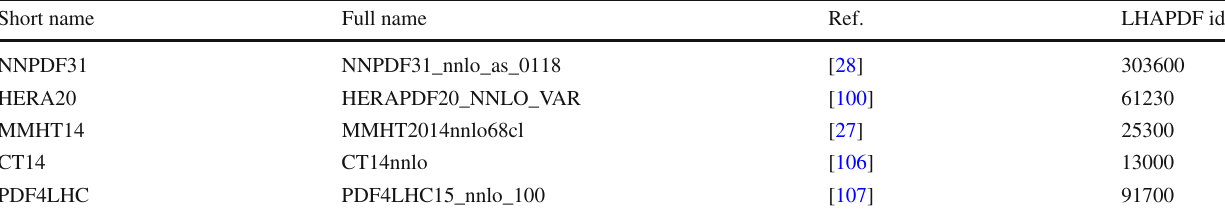
Table 4 List of collinear PDF used as the boundary for unpolarized TMDPDF